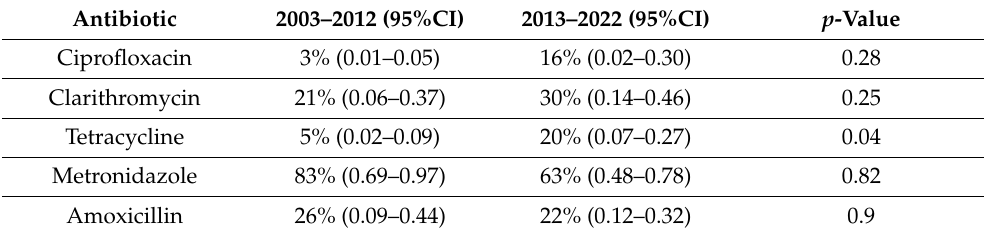
Table 3. Analysis of antibiotic resistance in 10-year intervals from 2003 to